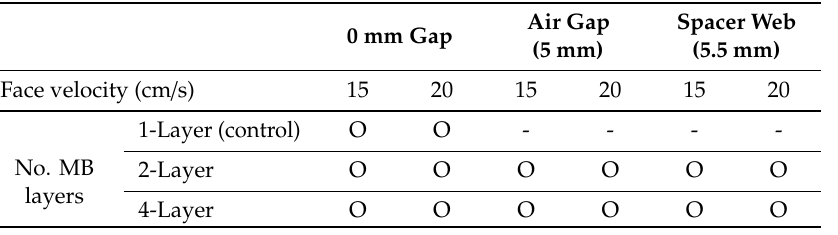
Table 2. Test variables.